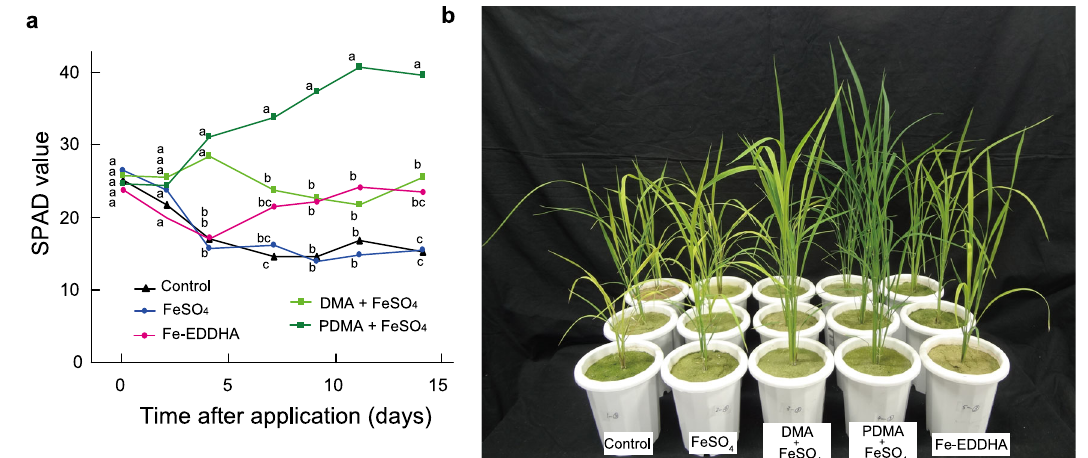
Fig. 4 Effects of PDMA, a synthetic DMA derivative, on rice in calcareous soil. a SPAD values of the newest leaves after a single application of the Fe chelates at 4 days after transplantation. DMA and PDMA were mixed with equimolar FeSO 4 in water before application. Values are the means of three replicates in which each replicate is average of three plants in each pot. Different letters indicate signi fi cant differences at P < 0.05 by Tukey ’ s honestly signi fi cant difference test (two-sided). P -values for one-way analysis of variance (ANOVA) are follows: 0 days, 0.9394; 2 days, 0.2530; 4 days, 0.0008; 7 days, <0.0002; 9 days, <0.0001; 11 days, 0.0002; 14 days, <0.0001. b Rice plants at 14 days after a single application of the Fe chelates. DMA 2 ′ -